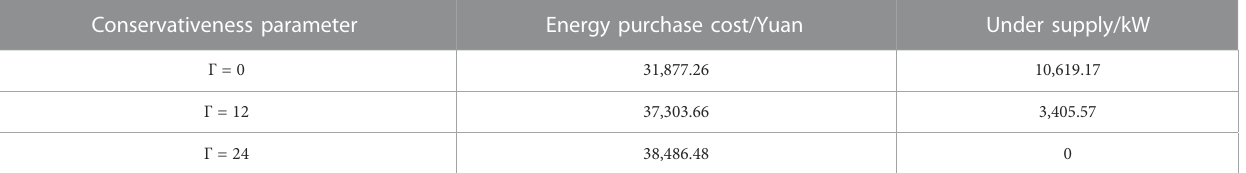
TABLE 2 Simulation results of scenario